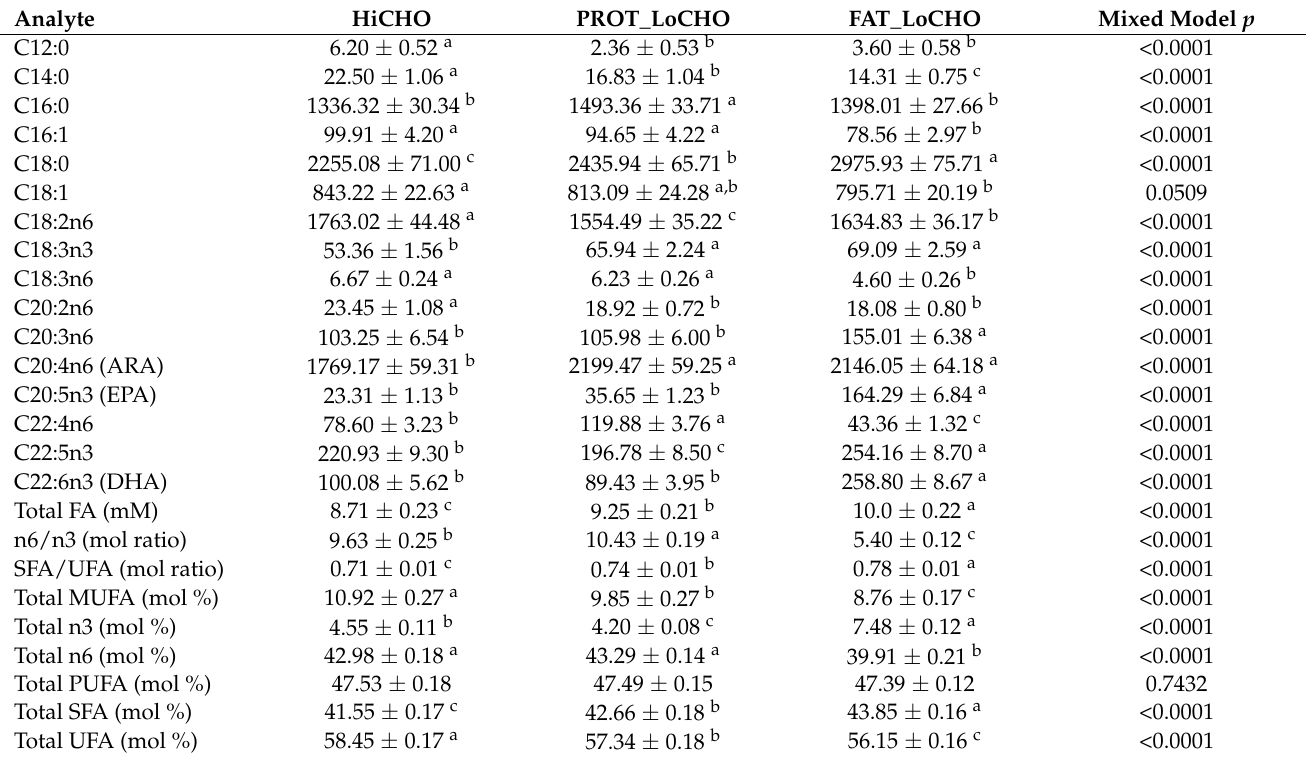
Table 6. Serum total fatty